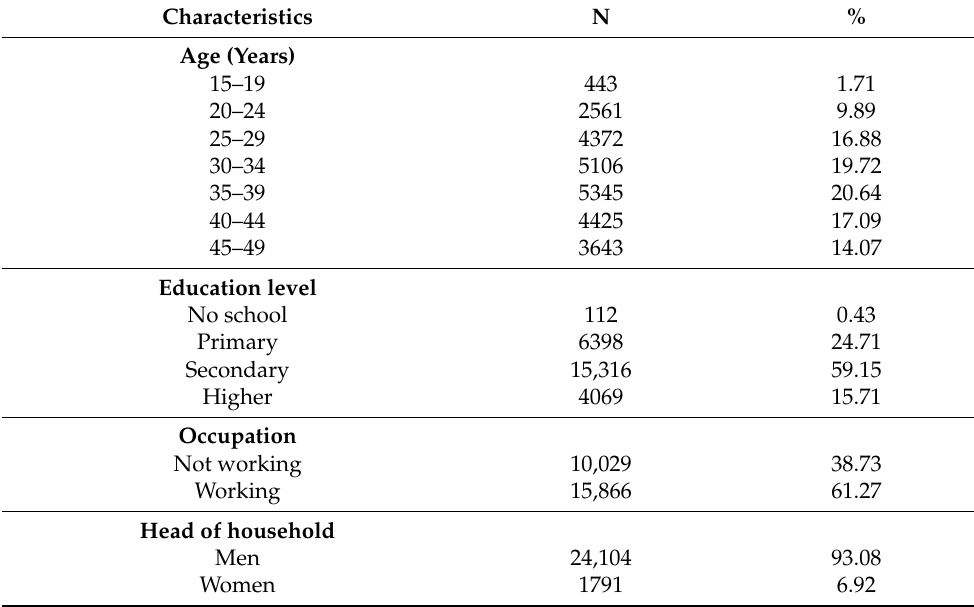
Table 1. Characteristics of women aged 15–49 years in